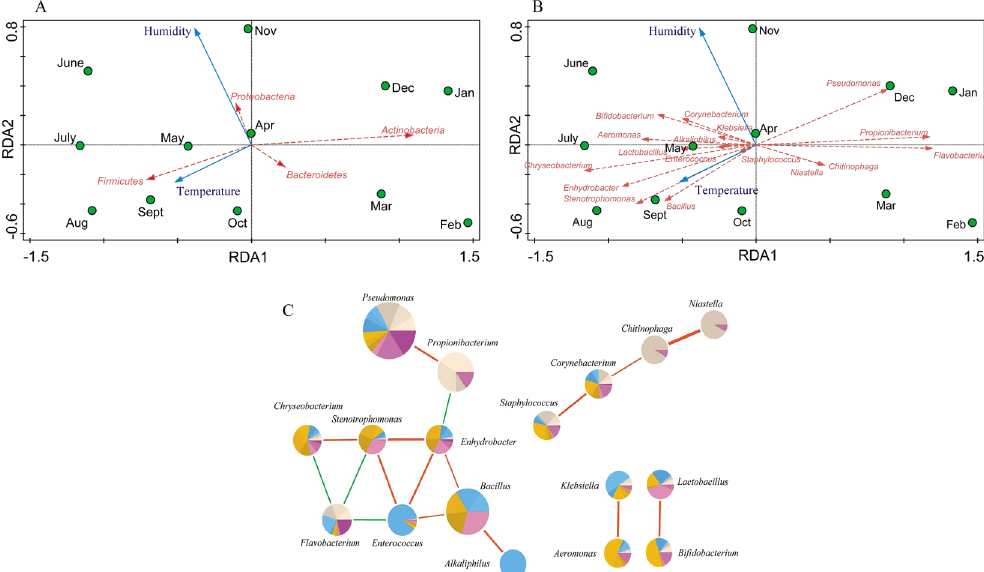
Figure 7. ( A ) Redundancy analysis (RDA) of the relationship between the environment factors and the relative abundance of bacterial phylum of 12 months’ samples. ( B ) Redundancy analysis (RDA) of the relationship between the environment factors and the relative abundance of bacterial genus of 12 months’ samples. ( C ) Correlation of 17 major genera. Line: orange-red (positive relation) and green (negative relation). Line weight: correlation strength. Circle size represented the reads numbers. The pie chart presented relative proportion in 12 months, seashell series: 1–3 months, blue series: 4–6 months, orange series: 7–9 months, orchid series: 10–12